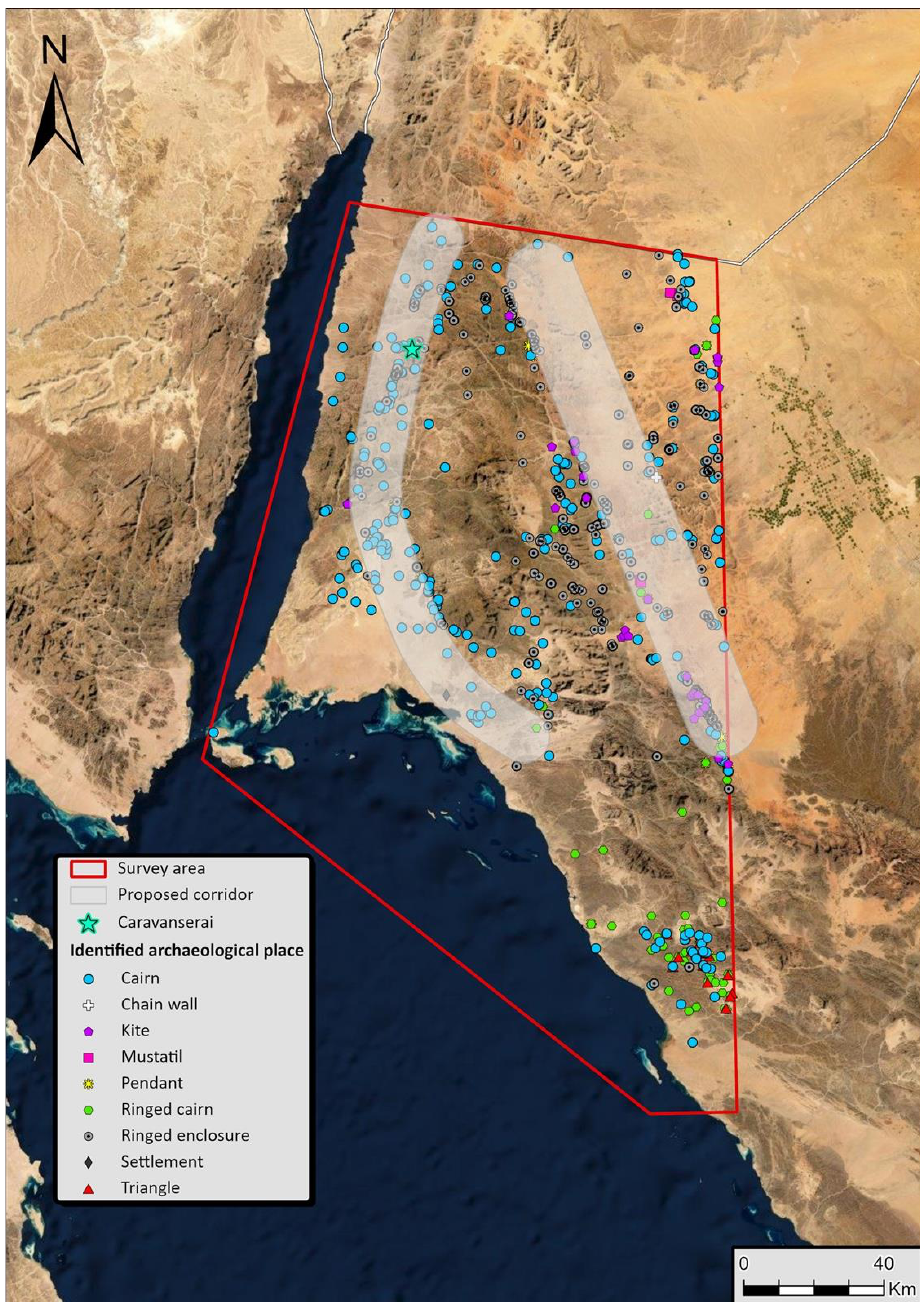
Figure 7. The east and west site ‘corridors’ .